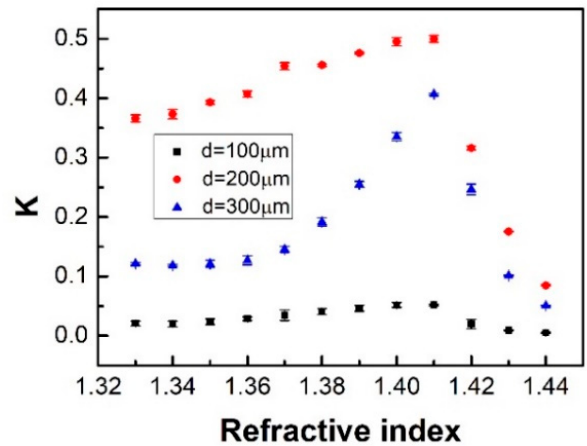
Figure 5. RI sensing performances for the sensors with the active fiber diameter of 200 μ m and passive fiber diameters of 100, 200, and 300 μ m. The twisted region length was 12 mm. Table 2. The sensitivity results from Figure 5.